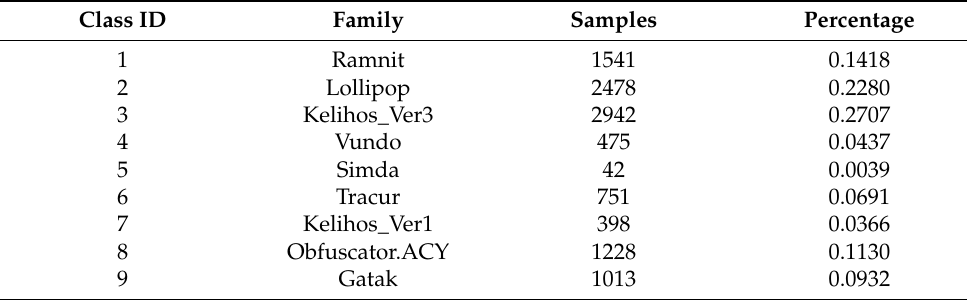
Table 2. Number of samples for each malware family in the Microsoft